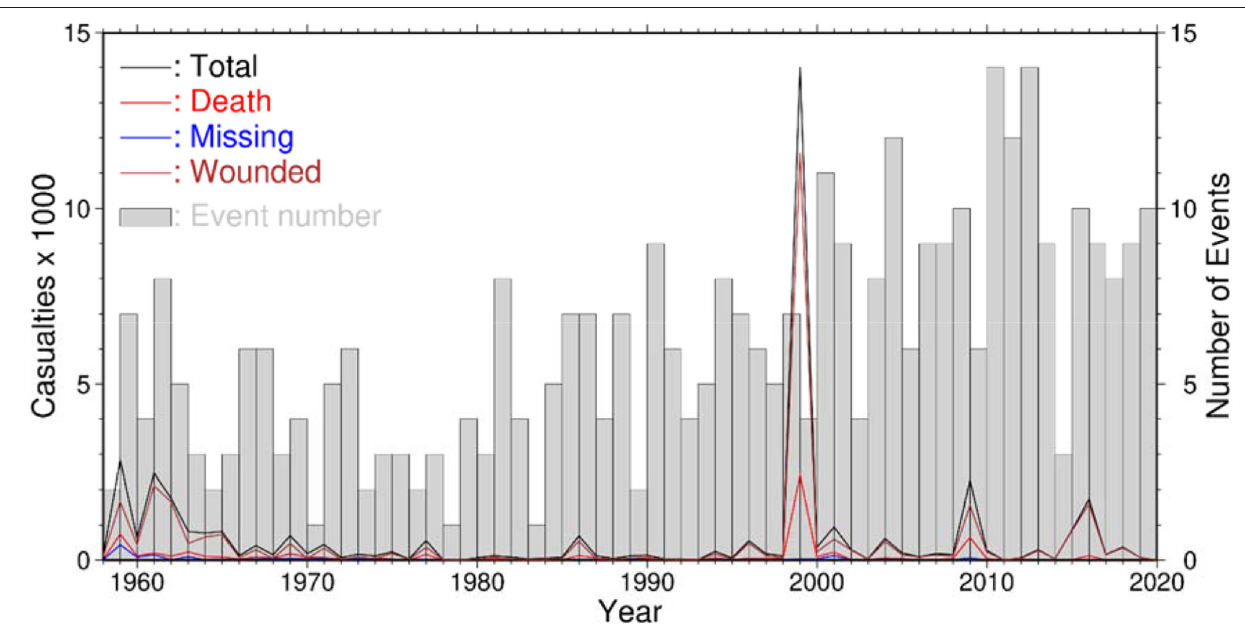
FIGURE 2 | Annual number of natural disasters and corresponding casualties from 1958 to